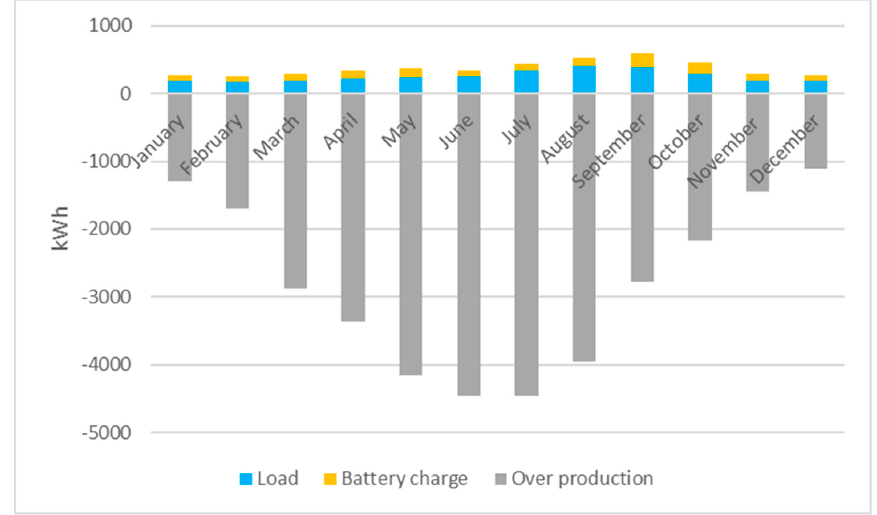
Figure 10. Energy flows for the stand-alone PV configuration (case b ).